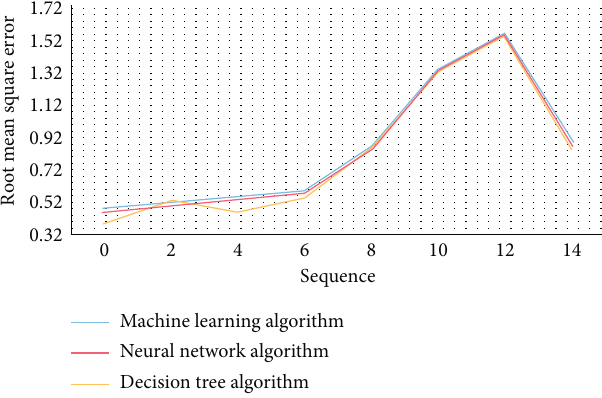
Figure 5: Comparison of root mean square error of three